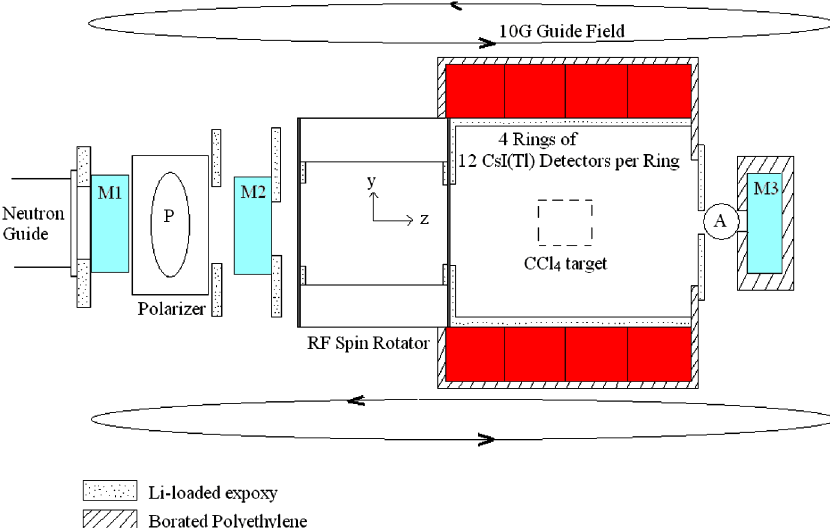
FIG. 1. (Color) A schematic side view (not to scale) of the NPDGamma apparatus and setup for the spin-flip efficiency measurement on 1FP12 at LANSCE. M1, M2, and M3 are 3 He ion chambers. The polarized 3 He spin filter cell P is placed between M1 and M2 and the polarized 3 He analyzer cell A is mounted in the front of M3 which is 1.65 m downstream from the exit window of the neutron guide. The analyzer cell and M3 are used for a measurement of the spin-flip efficiency and to monitor the polarization of the beam passing through the liquid parahydrogen target (not shown in the figure). Beam collimators are made from 6 Li -loaded epoxy material and neutron shielding from borated polyethylene. The entire apparatus is in a uniform 1 mT magnetic field.